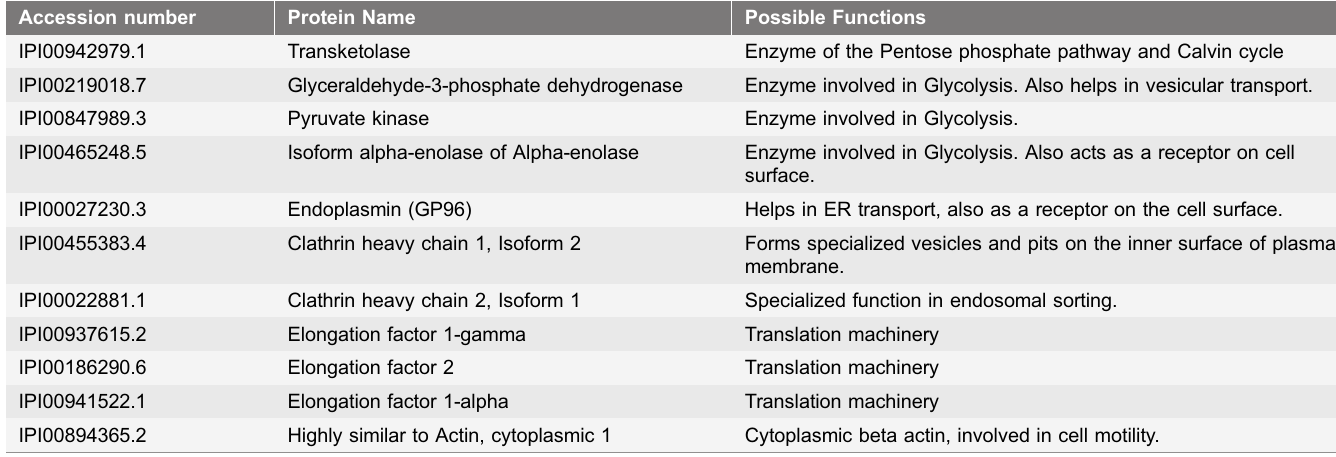
Table 1. Host proteins differentially immunoprecipitated with both HHV-6A and